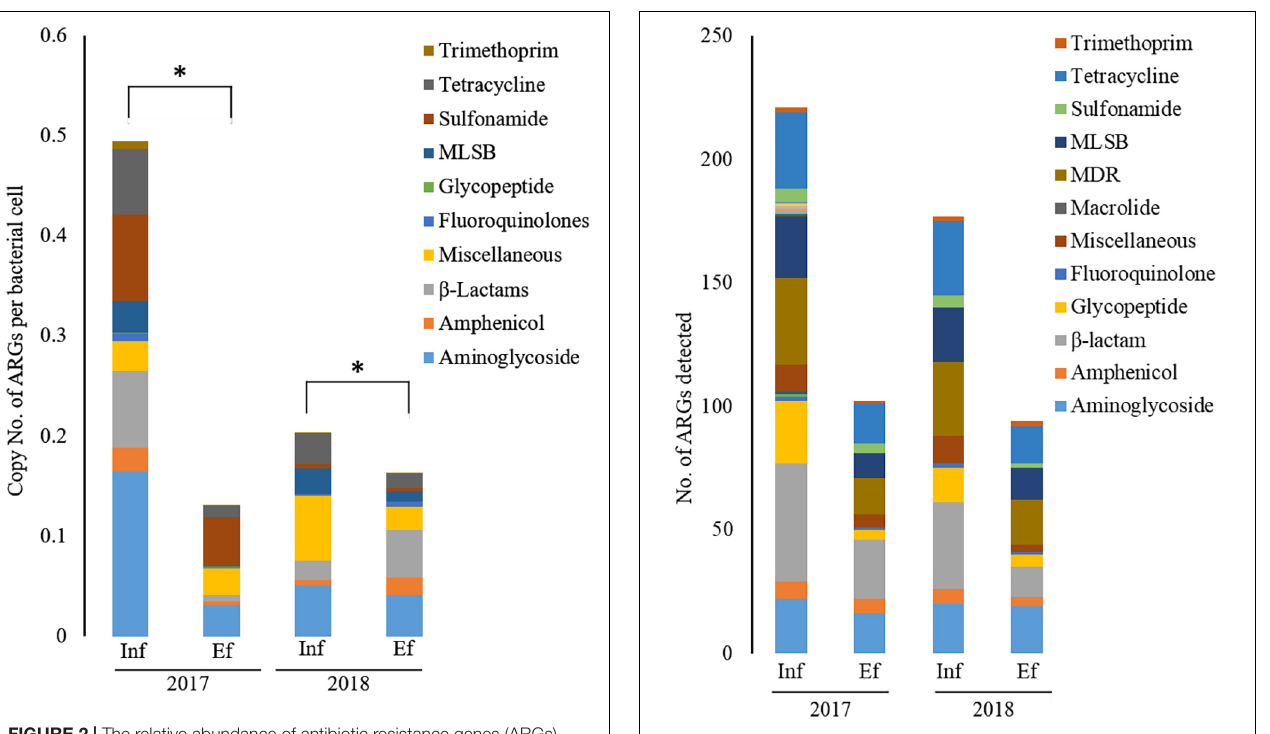
FIGURE 3 | The number of ARGs from the influent (Inf) and the effluent (Ef) of wastewater treatment plants through SmartChip analyses. The number of detected ARGs was shown by ARG classes in the influent and effluent of 2017 and 2018. Each color indicates the classes of